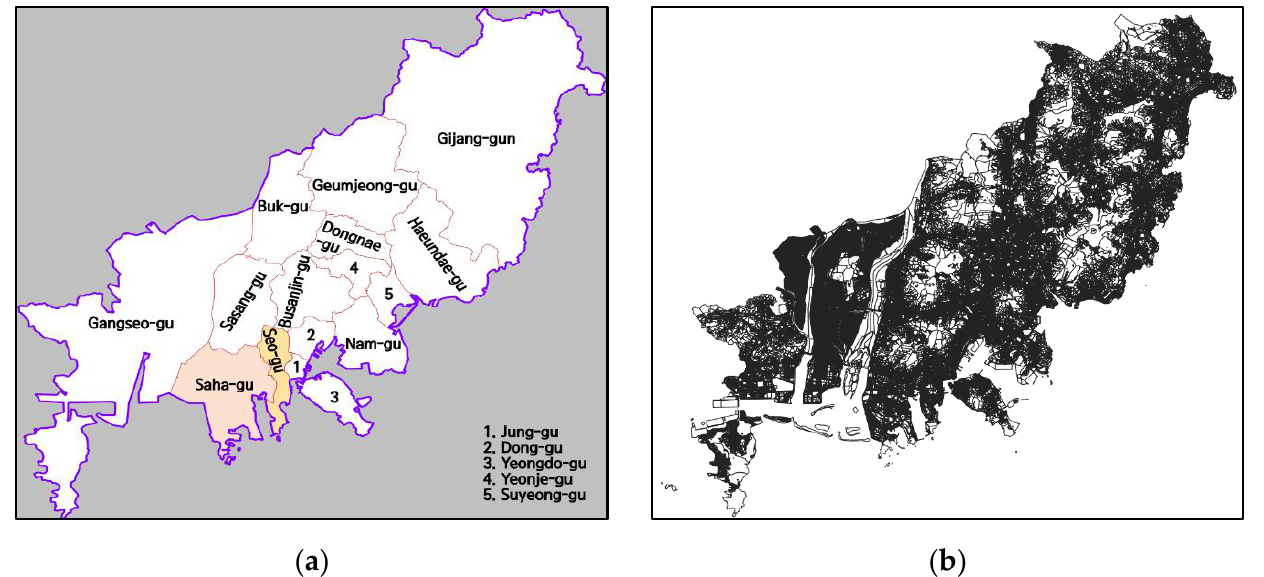
Figure 4. Map of Busan, Korea: ( a ) Administrative districts [34]; ( b ) vector image on a GIS application .